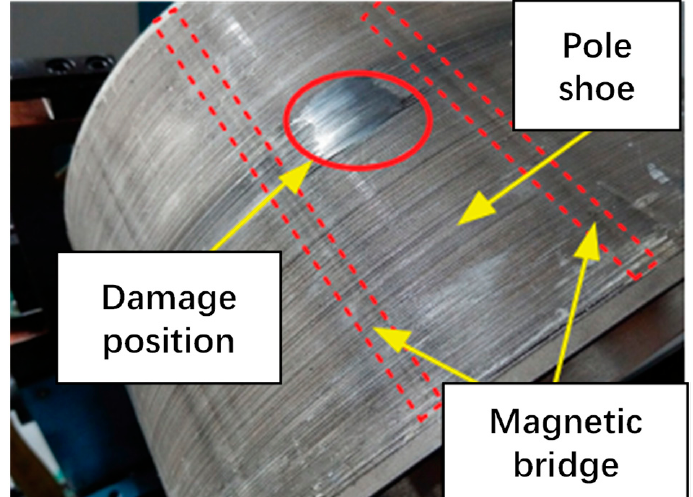
Figure 19. The failure diagram of the rotor.